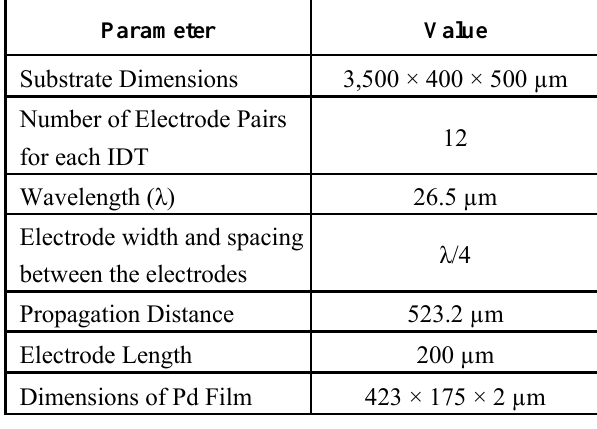
SAW sensor model. 3